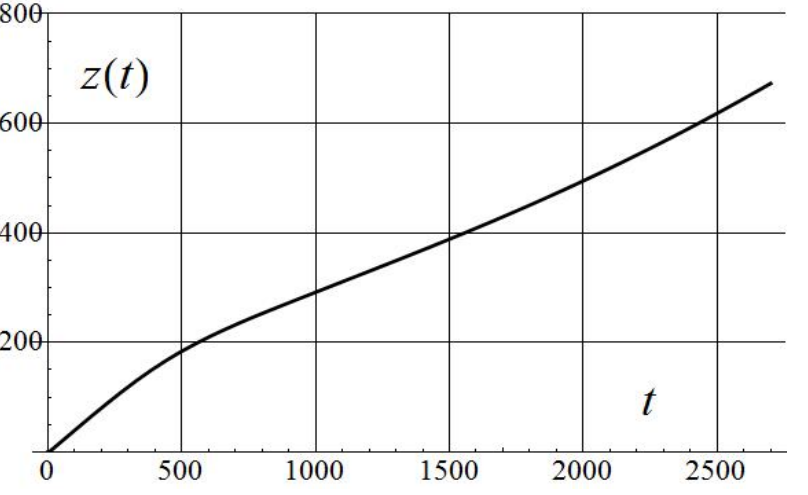
Figure 19. Submersion versus time: equatorial waters, steel sphere C D = 0.4, η = 0.007.